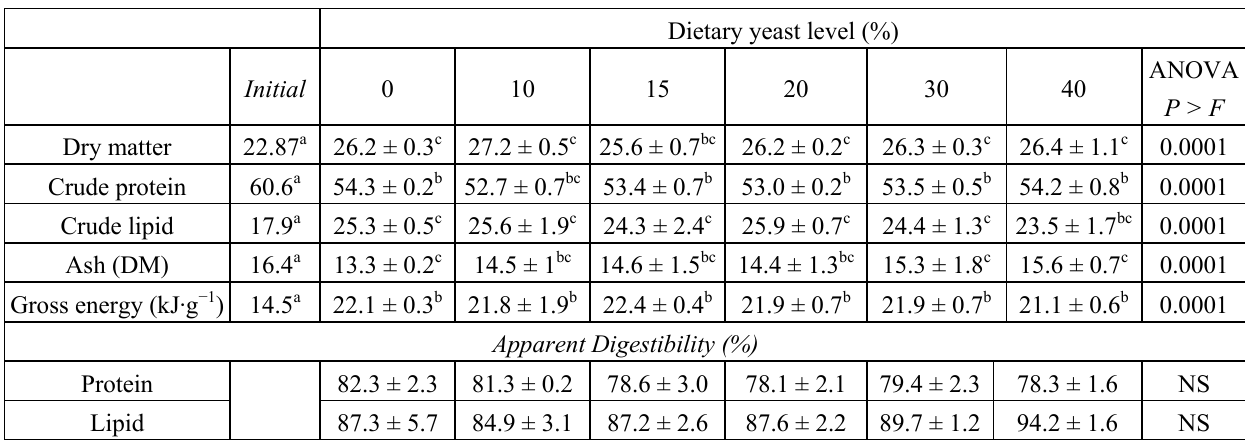
Table 3. Effect of different dietary yeast levels on whole-body composition and nutrient digestibility in juvenile tilapia (7.6 ± 0.3 g) fed over 51 days (% dry matter basis, unless otherwise